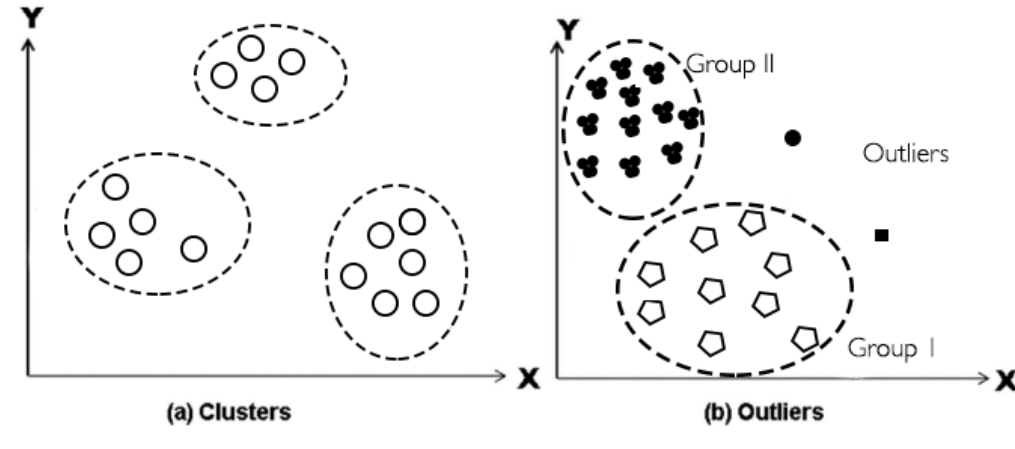
Figure 1. Classification based anomaly detection from [24].